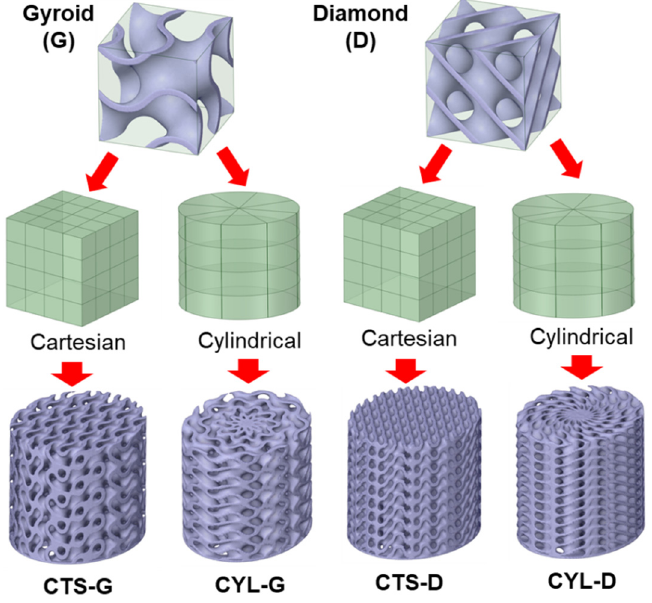
Figure 2. Design of TPMS structures with different combinations of unit cells and base coordinates. Table 2. Comparison of TPMS structures with different combinations of unit cells and base coordi- nates.